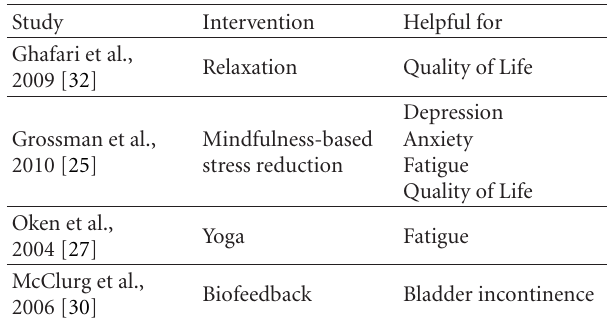
Table 4: Of 10 studies reviewed, four high quality studies were found helpful for symptoms of